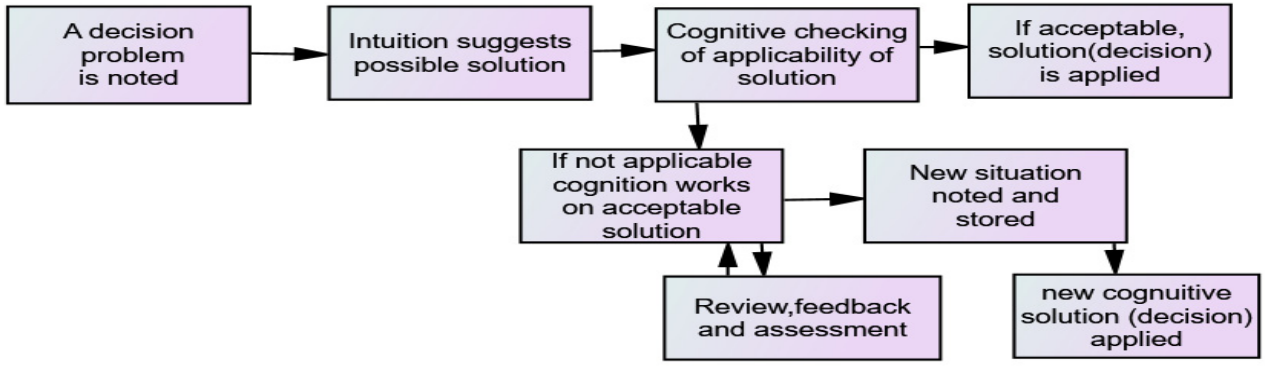
Figure 4. Possible pathways in the OII process. (iv) Testing for OII skill.